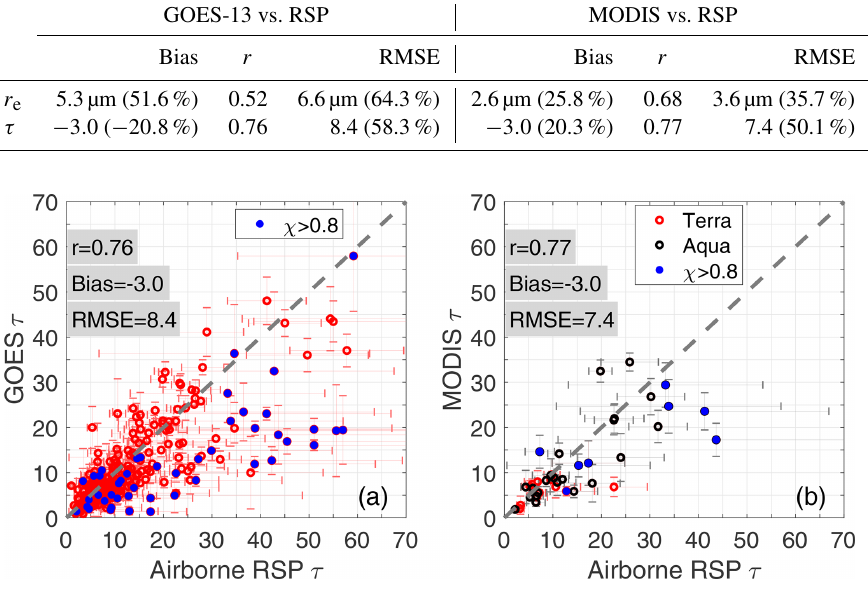
Figure 6. As Fig. 5 but for the comparison between airborne RSP τ and (a) GOES-13 and (b) MODIS.